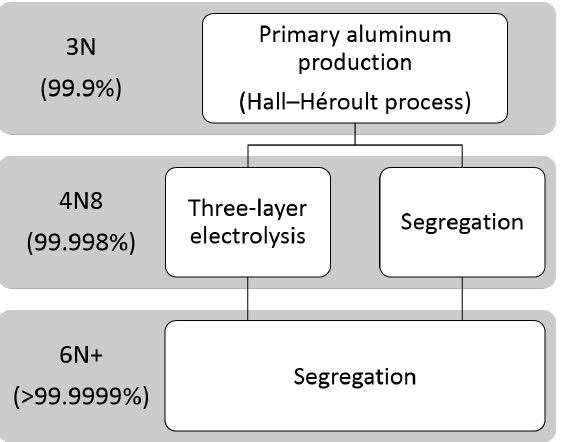
Figure 1. The process of high- and ultra-high-purity aluminum